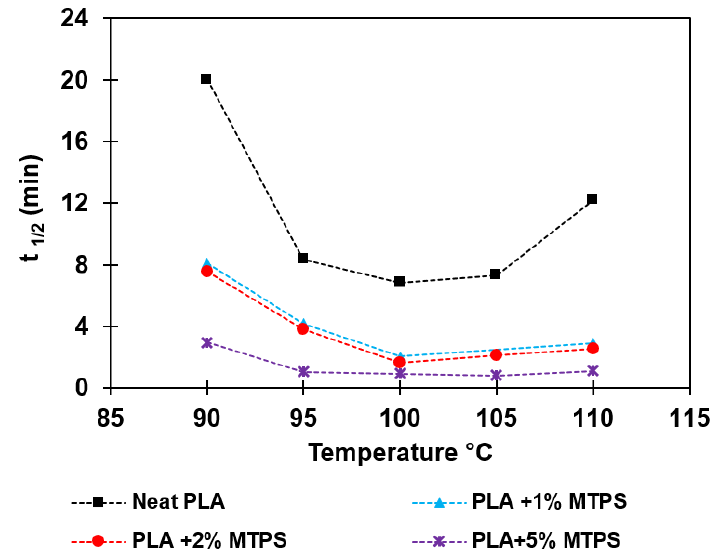
Figure 13. Half time for crystallization vs isothermal crystallization temperatures for PLA and blends.